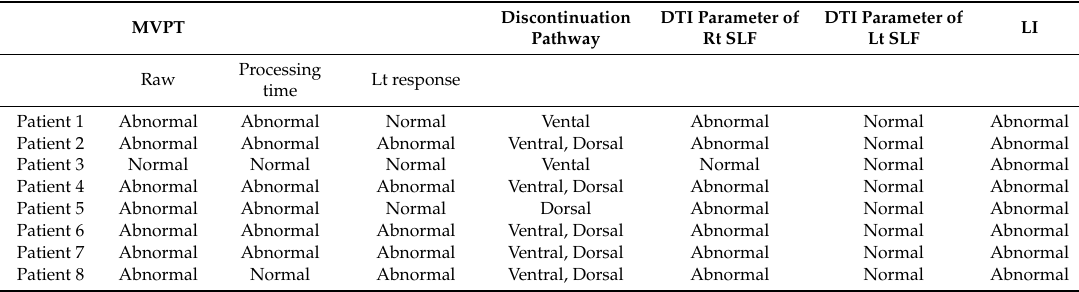
Table 5. A summary table of the results obtained for components of the MVPT and DTI parameters and LI-TV in the patient group ( n =